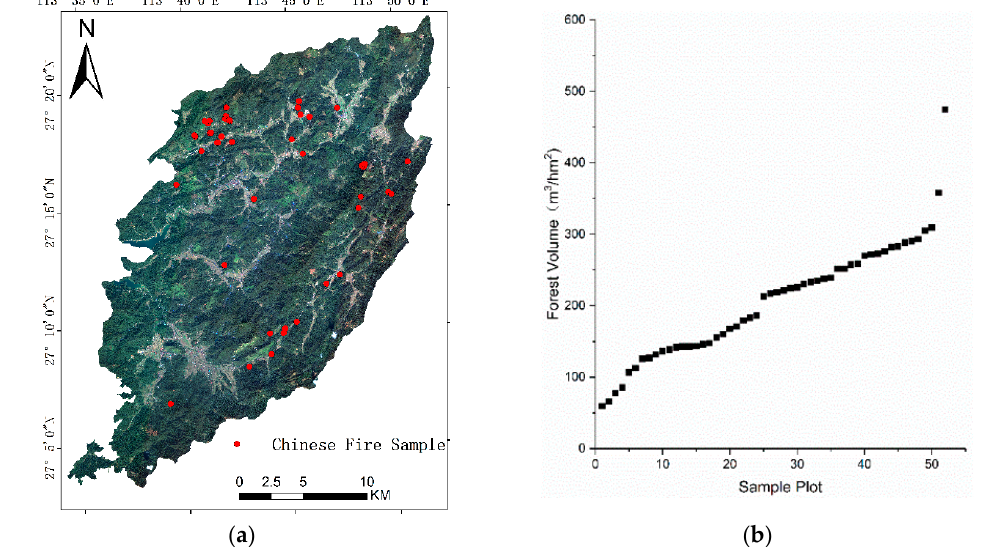
Figure 2. Spatial distribution of samples. ( a ) The map of ground samples; ( b ) the range of measured GSV. (2)